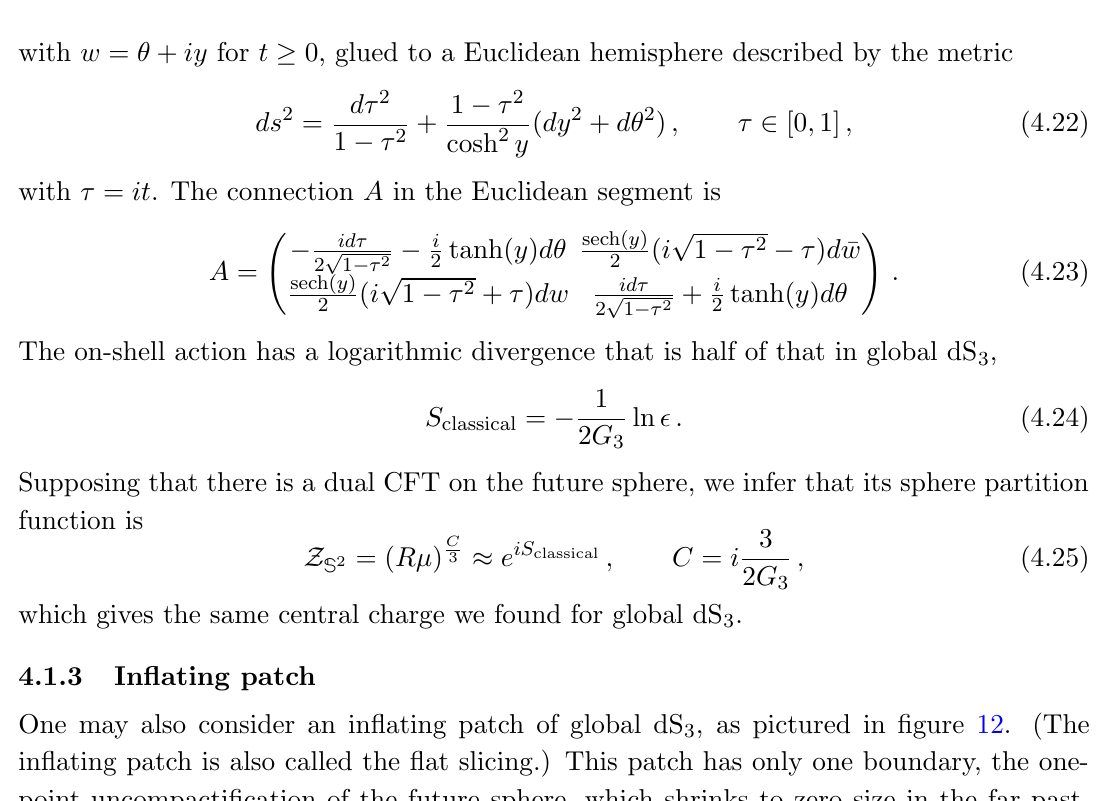
Figure 12 . The Penrose diagram for the in(cid:13)ating patch of dS 3 , depicted in light blue. The constant-time slices (i.e., \(cid:13)at slicings") are shown in